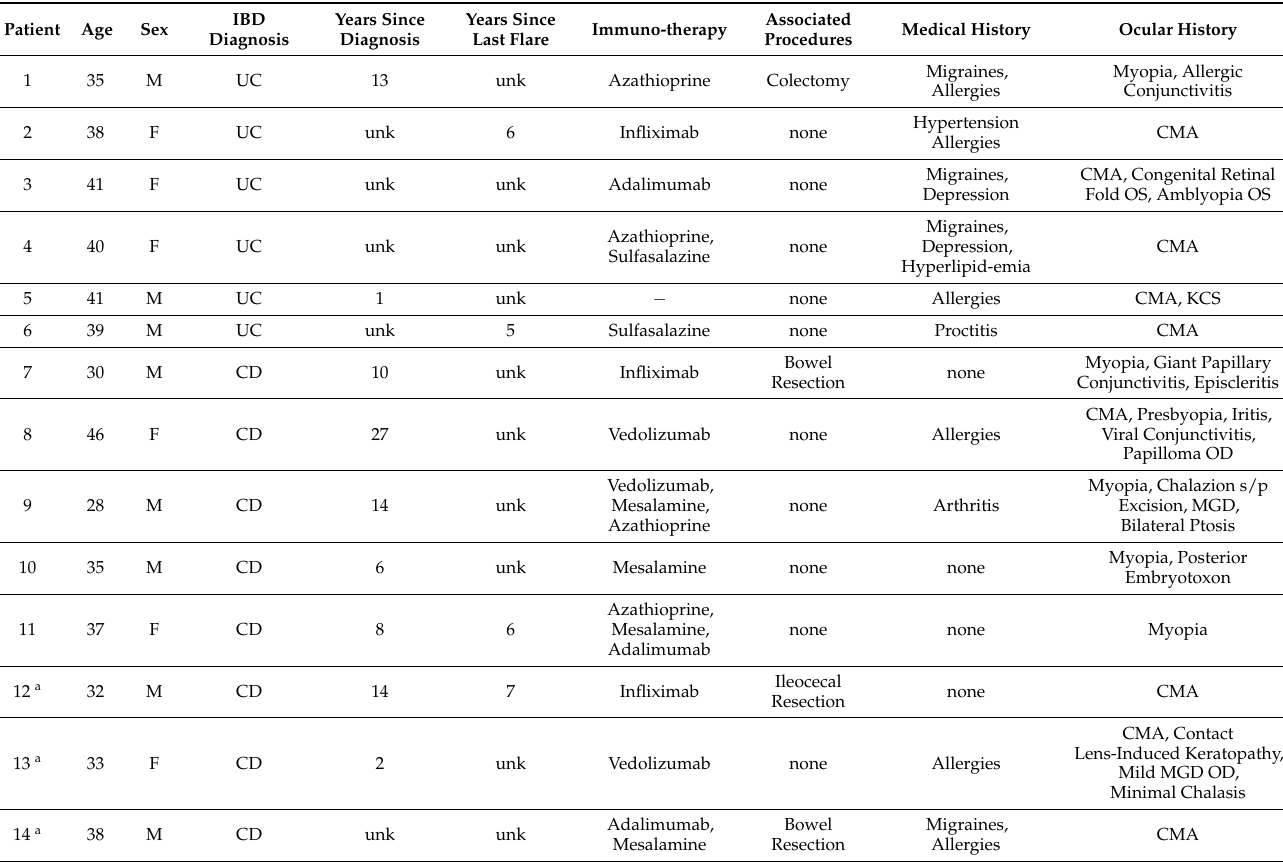
Table 1. Patient